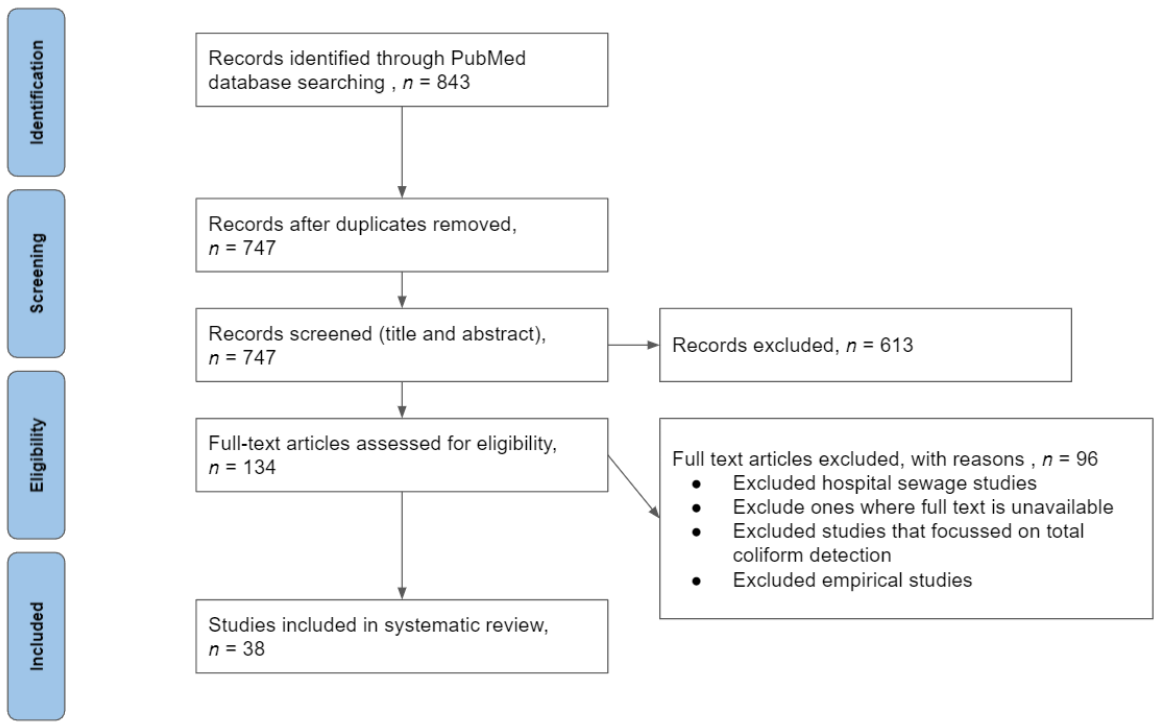
Figure 1. PRISMA flowchart of the systematic review process and article screening results.